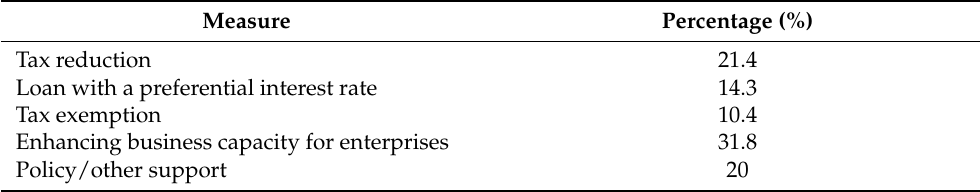
Table 4. Local authorities’ policy and support (n = 280).